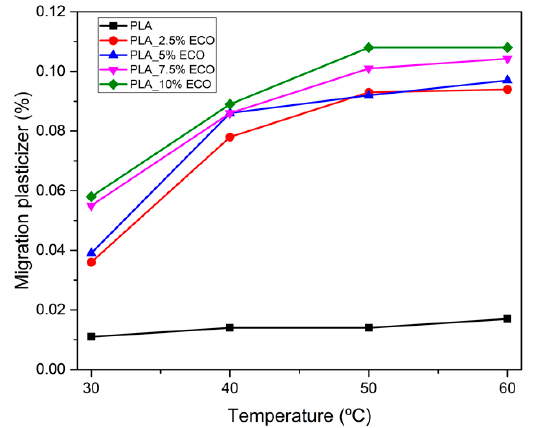
Figure 10. Migration of epoxidized chia seed oil (ECO) plasticizer in PLA matrix by n-hexane solvent extraction.